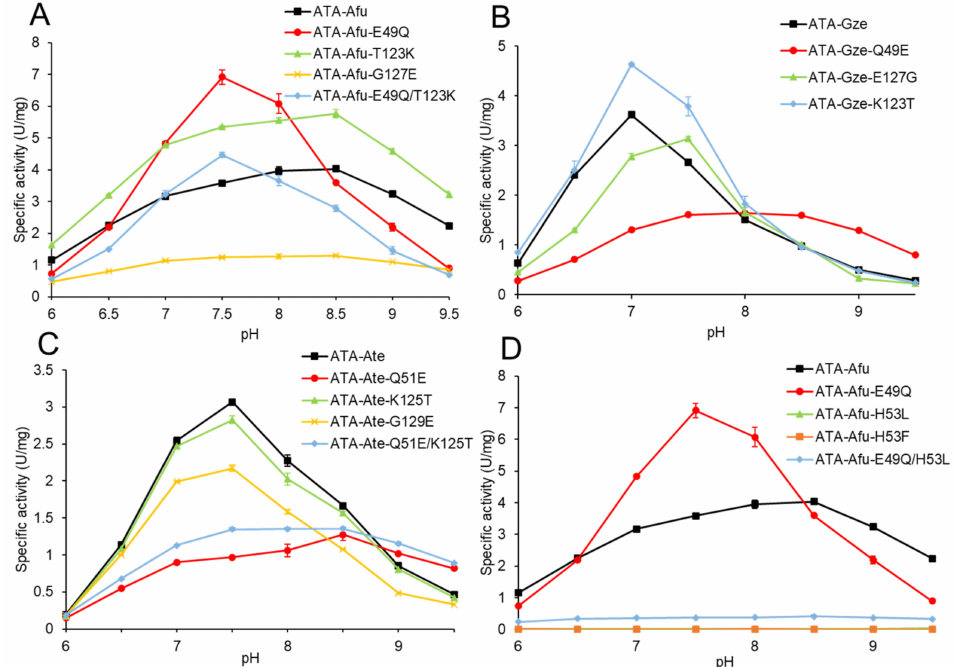
Figure 3. pH activity profiles of wild-type and variants of ATA-Afu ( A , D ), ATA-Gze ( B ) and ATA-Ate ( C ). The pH optimum was determined by assessing the specific activities using the acetophenone assay at different pH conditions. Data points correspond to the mean values of three independent experiments. The error bars are shown in the figure and the detailed data for specific activity measurements are given in Table S2. The kinetic parameters are shown in Table S3 and Figure